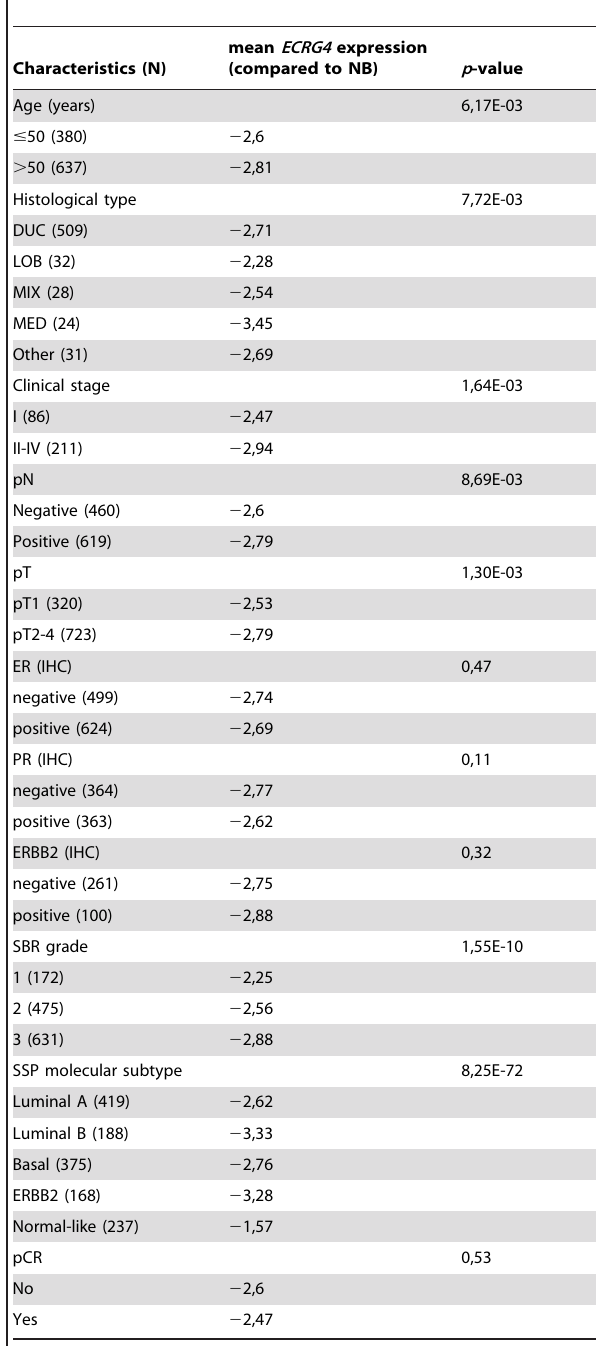
Table 2. Correlation of ECRG4 expression and histoclinical features